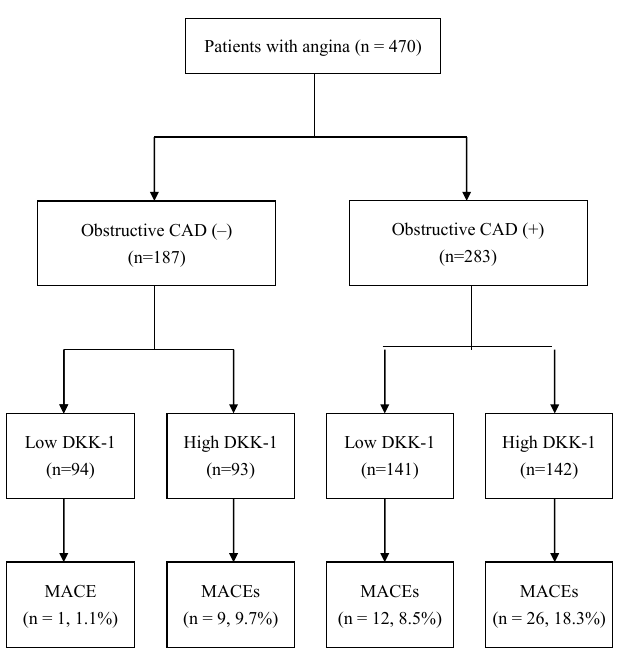
Figure 2. Flow diagram of the enrollment of the study participants. Abbreviation: CAD = coronary artery disease, DKK-1 = dickkopf-1, and MACEs = major adverse cardiac events.